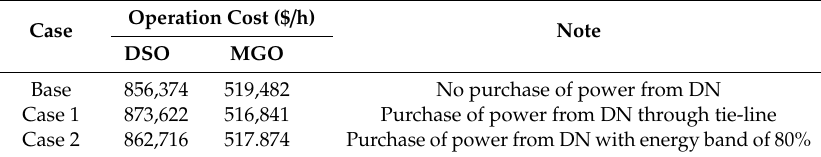
Table 3. Comparison of the operational costs for each case.